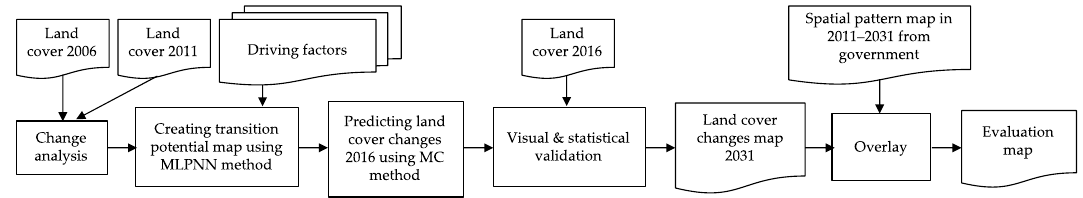
Figure 3. Land cover change modeling flowchart.